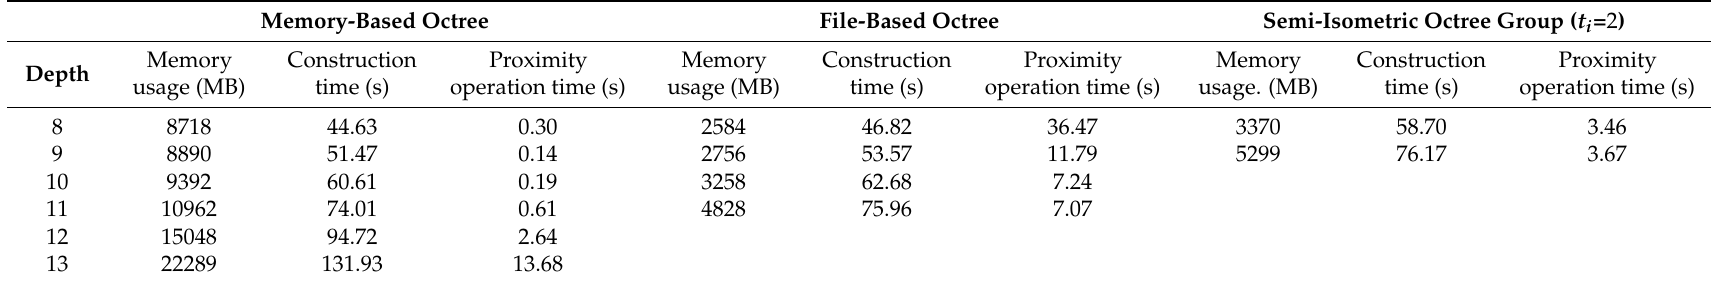
Table 9. Performance comparison among octree implementing methods using Data